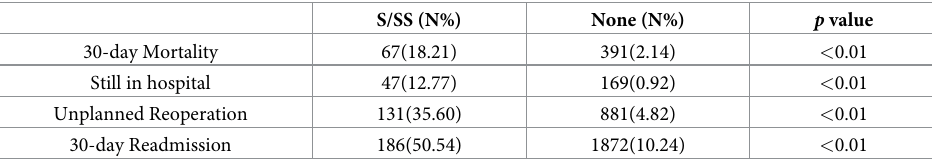
Table 3. Mortality, reoperation and readmission